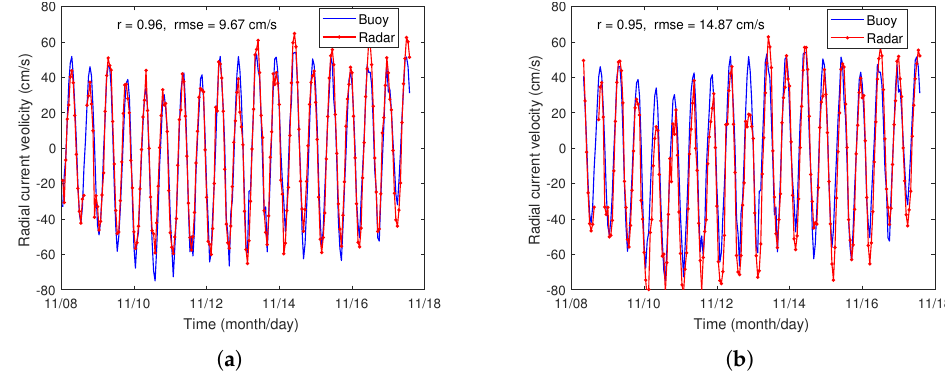
Figure 7. Comparison of hourly averaged radar-derived radial velocities with those recorded by the buoy (Figure 4). ( a ) radial current velocities extracted by proposed calibration method; ( b ) radial current velocities extracted by the conventional method. Correlation coefficient (r) and root-mean-square error (rmse) are shown in the top of each